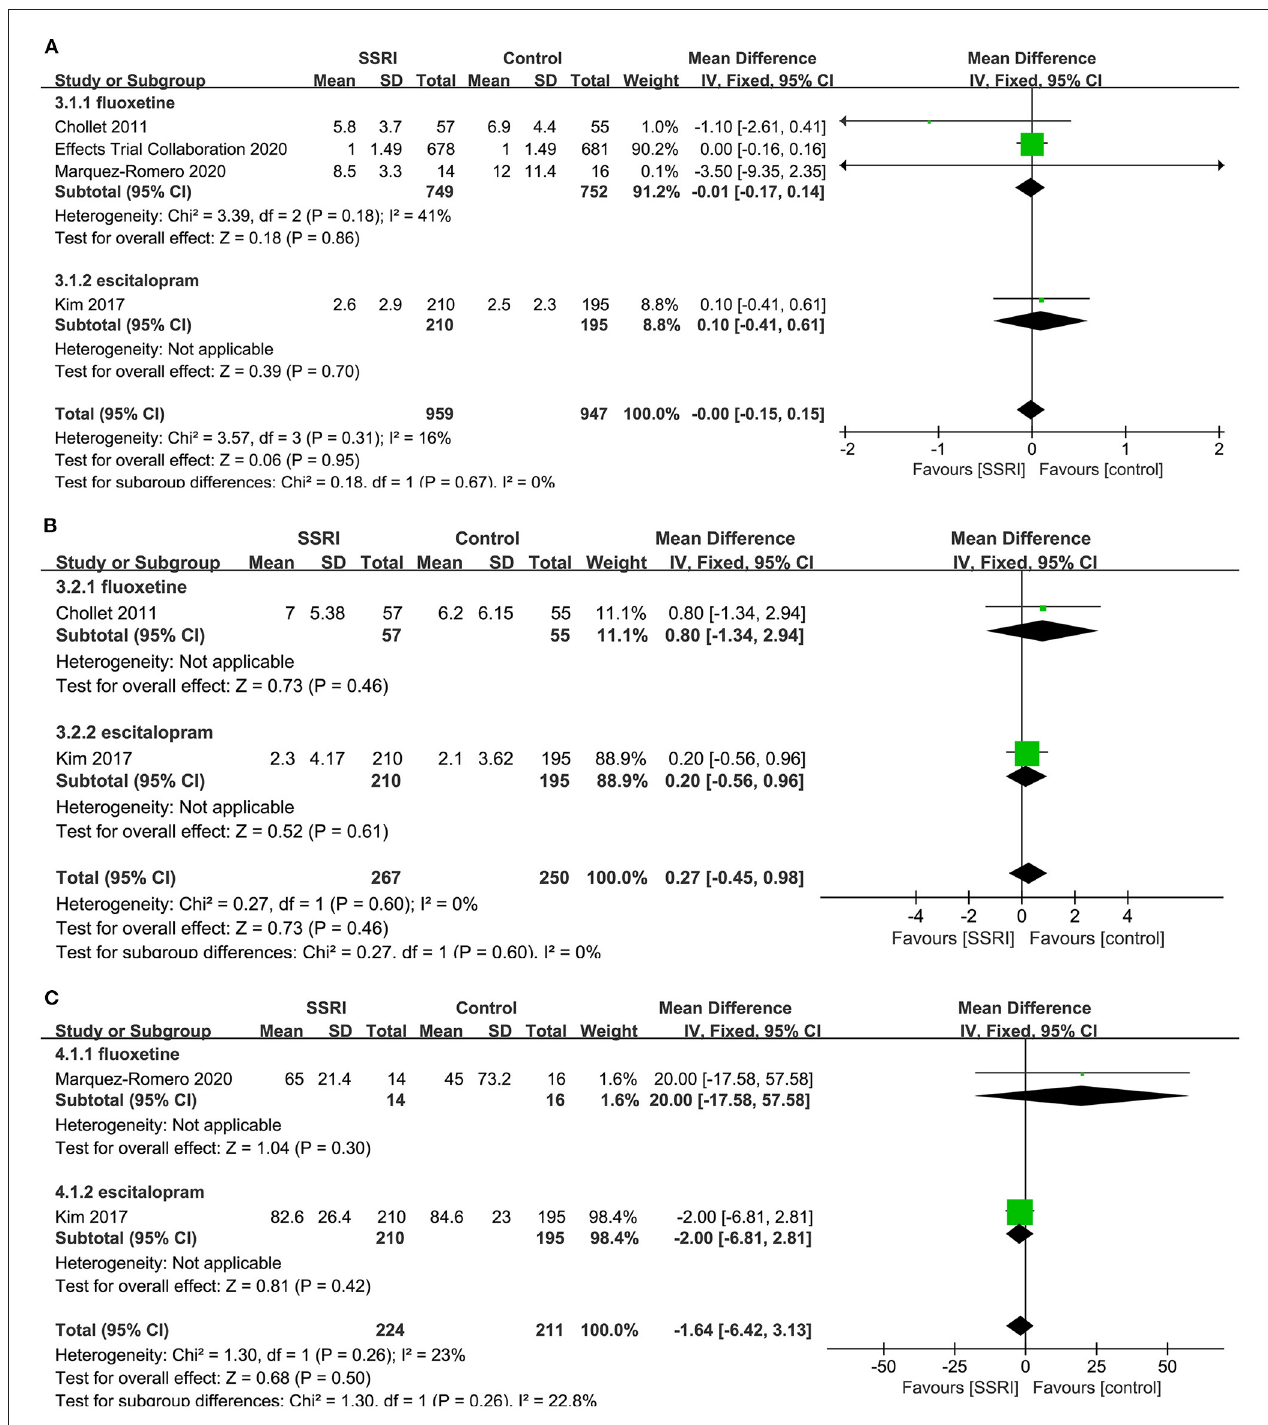
FIGURE 5 | Forest plot of secondary efficacy outcomes. (A) NIHSS-endpoint score, (B) NIHSS-mean change, (C) BI-endpoint score. NIHSS, National Institutes of Health Stroke Scale; BI, Barthel Index.